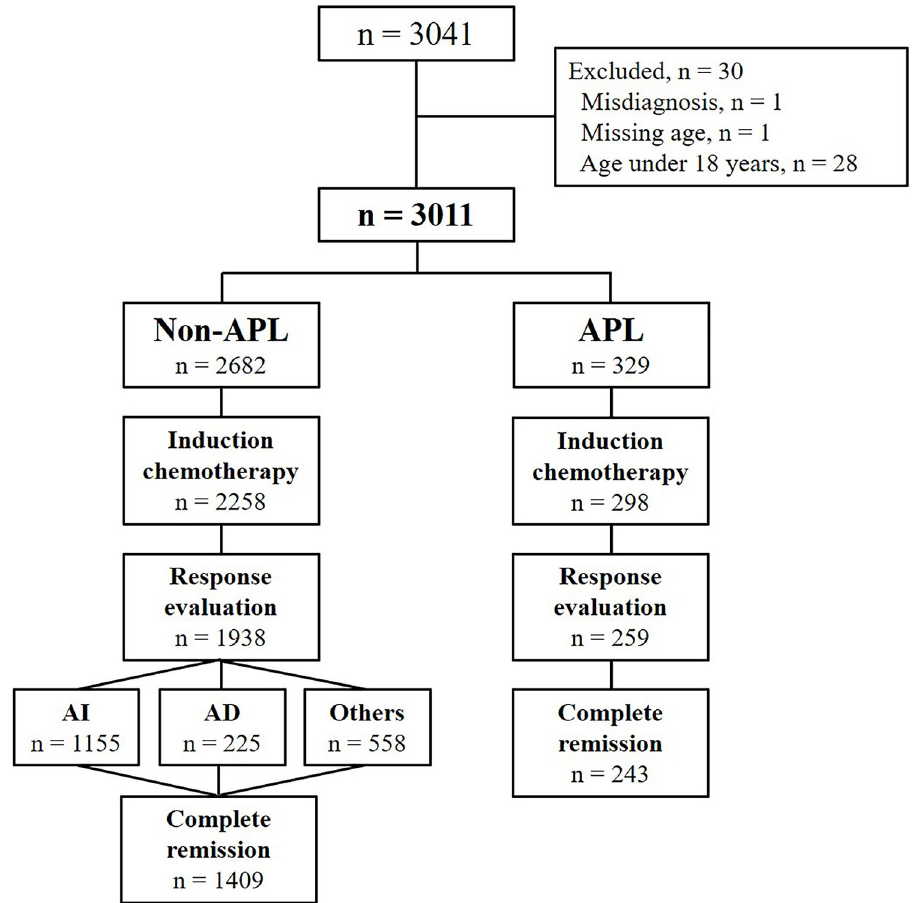
Fig 1. Flow diagram. APL: acute promyelocytic leukemia, AI: cytarabine plus idarubicin, AD: cytarabine plus daunorubicin.